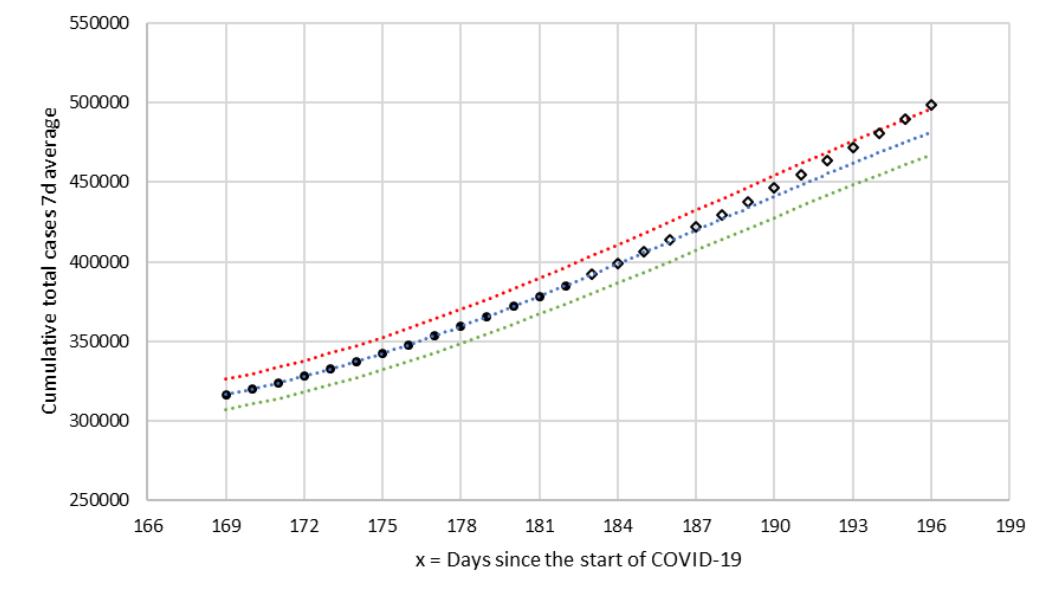
Figure 4. T-6 predictive segment calculated on 23 August between 10 and 23 August (x = 169 to 182). The black circles represent the 14 values used to obtain the curve y ∗ by linear regression. The rhombuses are the observed y ∗ values since 24 August. The ˆ y ∗ u and ˆ y ∗ curves were obtained by increasing and reducing the values of y ∗ by 3%. The standard equation: f